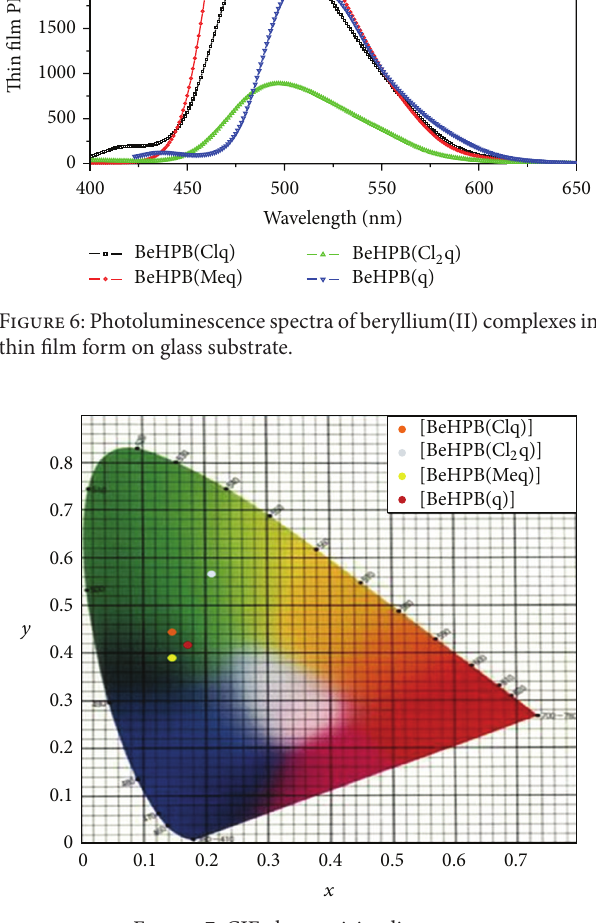
Figure 7: CIE chromaticity